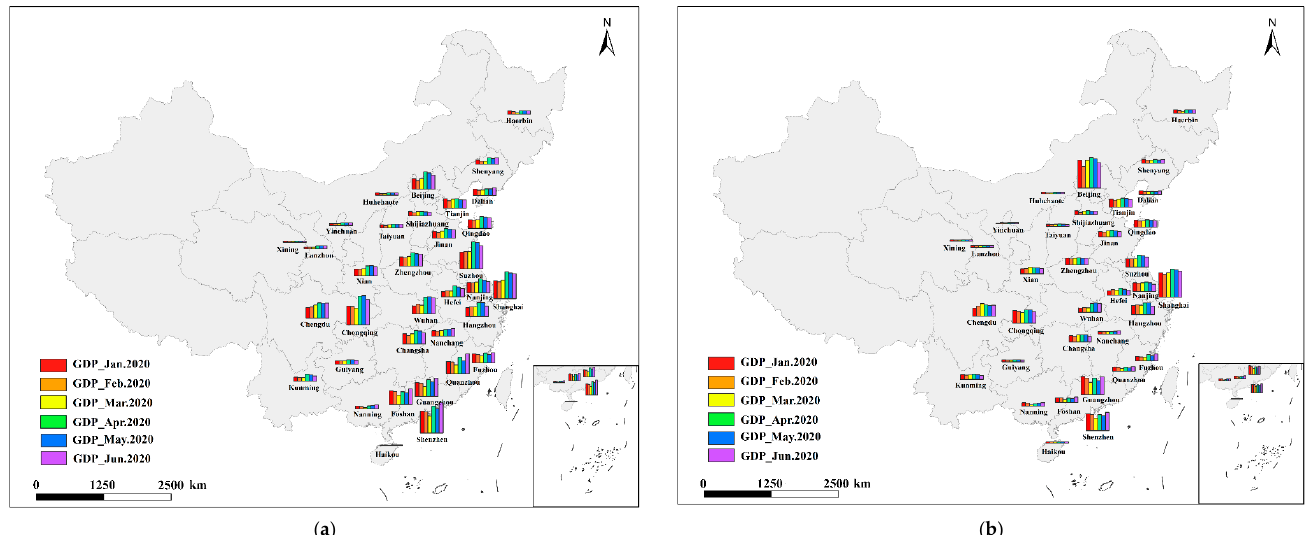
Figure 5. ( a ) The GDP changes of the secondary industry from January to June 2020; ( b ) The GDP changes of the tertiary industry from January to June 2020. Table 6. GDP of cities in the secondary industry from January to June 2020 (unit: 100 million yuan). City